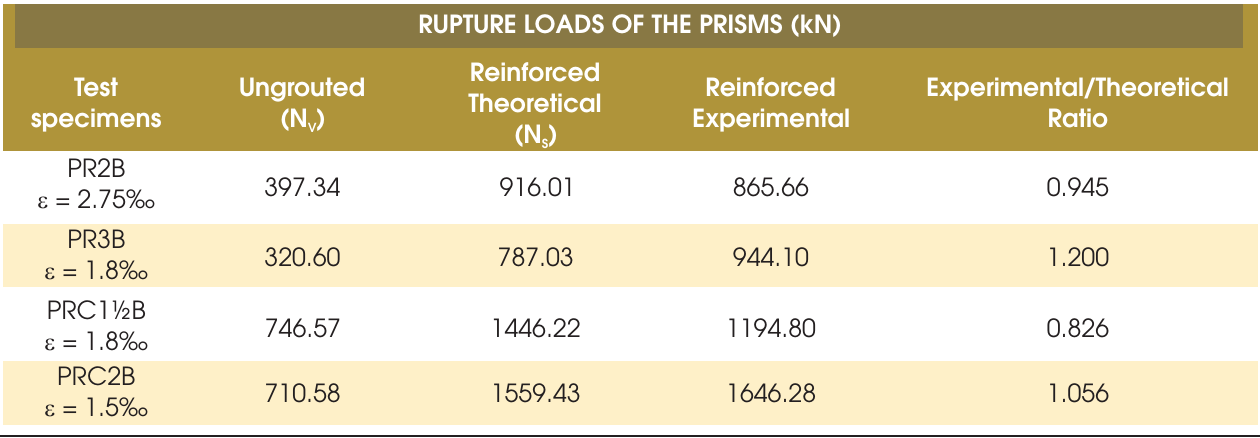
Table 10 – Comparison of mean theoretical and experimental loads for break strain (Model III – 2.0‰)